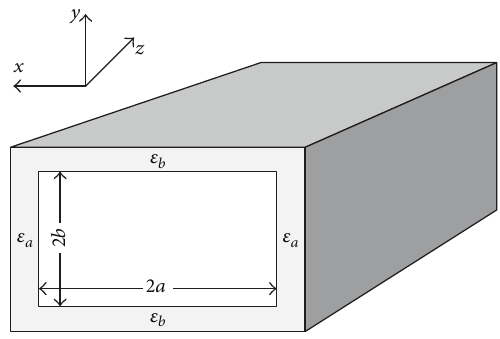
Figure 1: Geometry and parameters of a rectangular